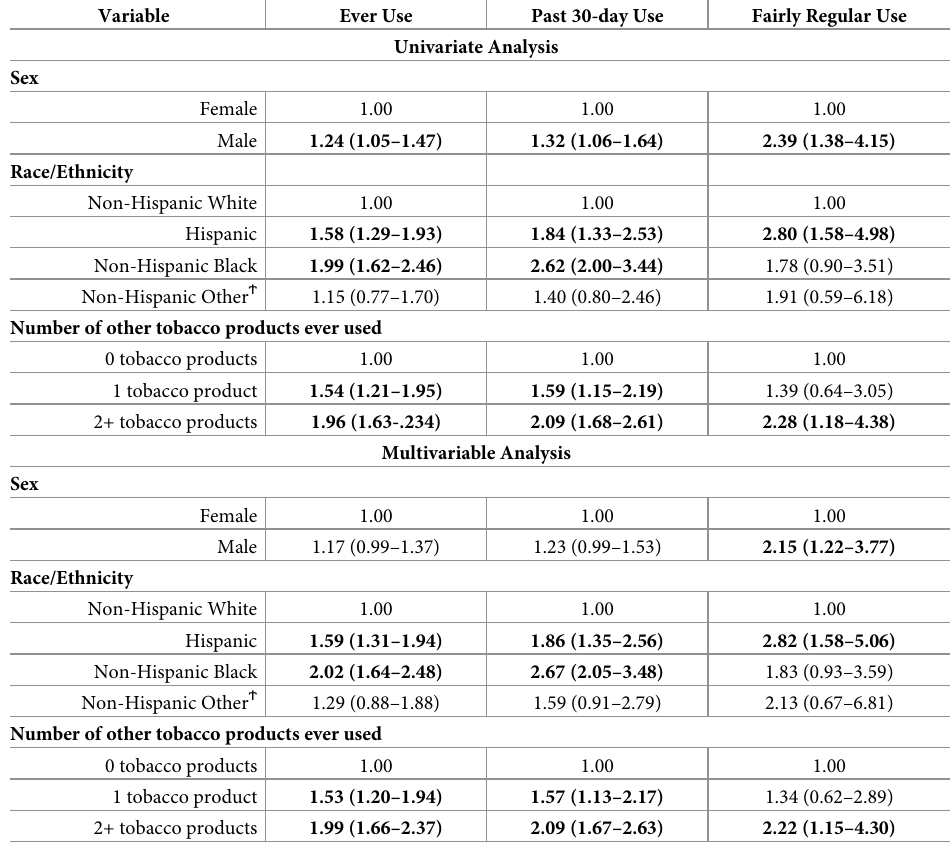
Table 3. Hazard ratios (and 95% confidence intervals) for each age of initiation of hookah use behaviors by sex, race/ethnicity, and other tobacco products